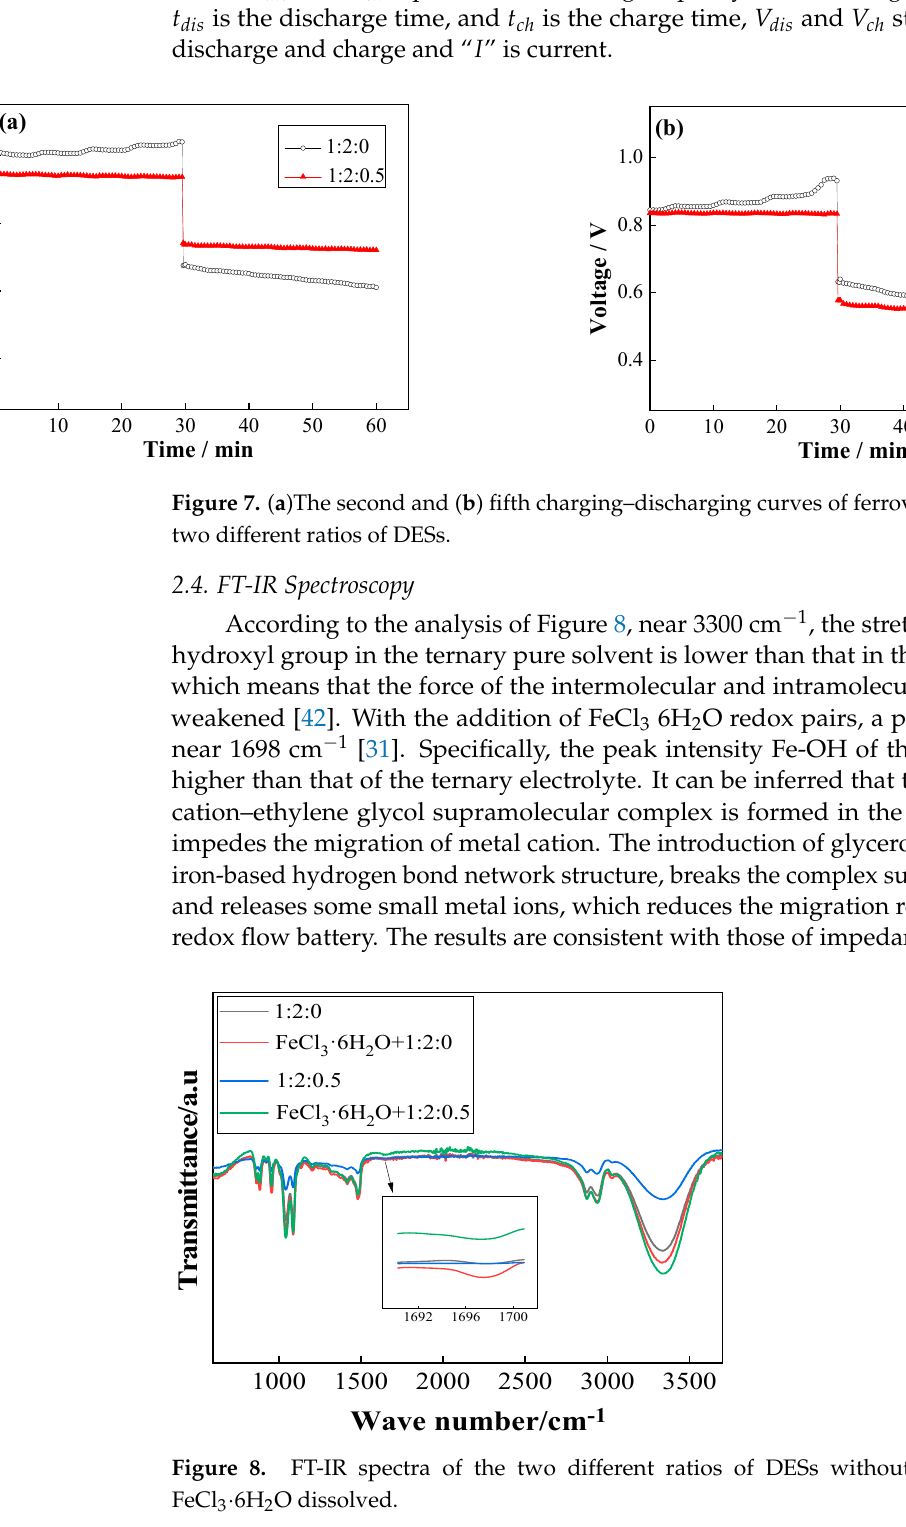
8 of 12 Figure 6. ( a )Assembly of ferrovanadium flow battery; ( b ) power density and I − V curves of ferro- vanadium flow battery with the two different ratios of DESs. The charge–discharge current density of the battery was set to 2 mA·cm − 2 , and the charge–discharge time was set to 30 min. According to the following Equations (1)–(3),